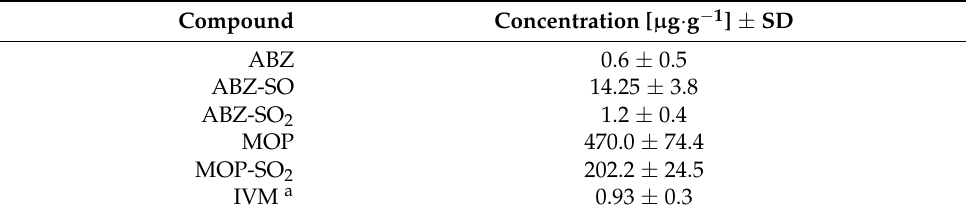
Table 1. Summarization of concentrations [µg·g − 1 faeces DW] of compounds in ovine faeces.